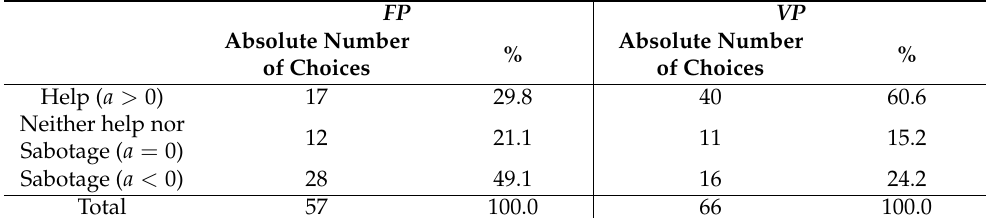
Table 3. The decision to help or sabotage in FP vs. VP .